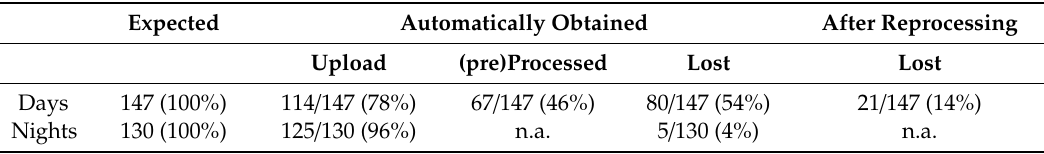
Table 1. Number and percentages of missing measurement days and nights. Measurement nights did not have any processing or reprocessing procedures and are therefore not applicable (n.a.).